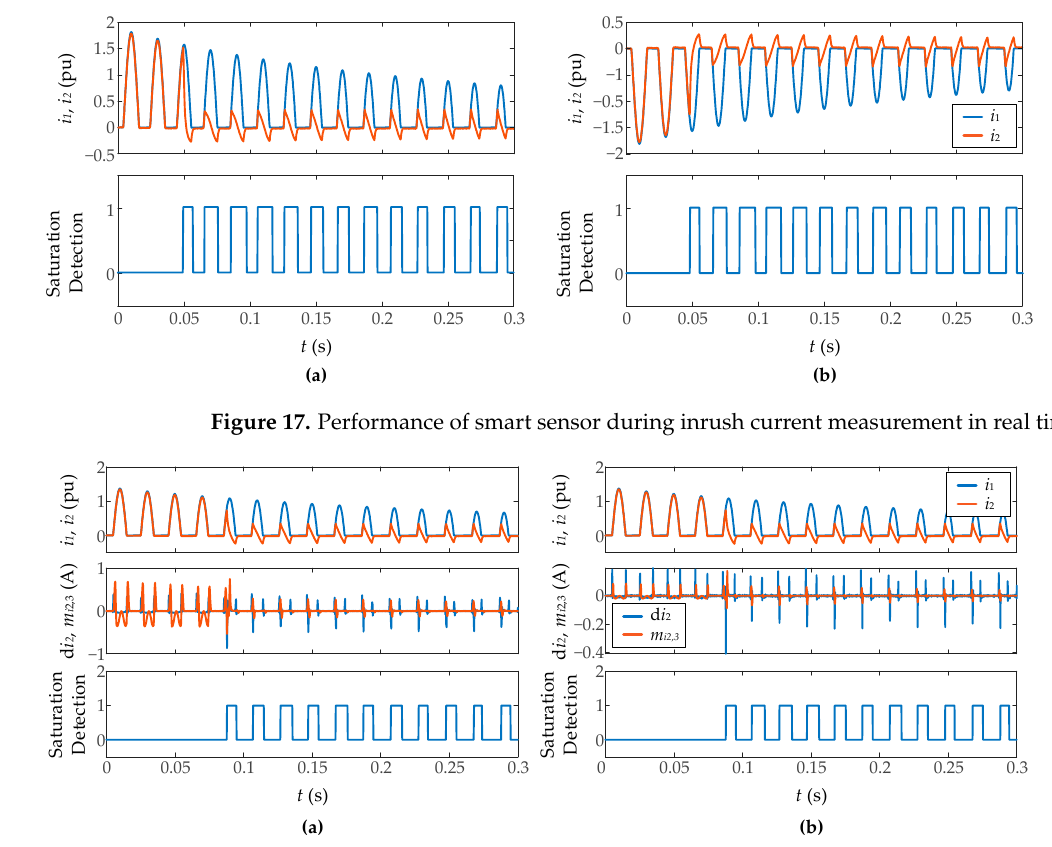
Figure 18. Performance of smart sensor during inrush current measurement in real time.